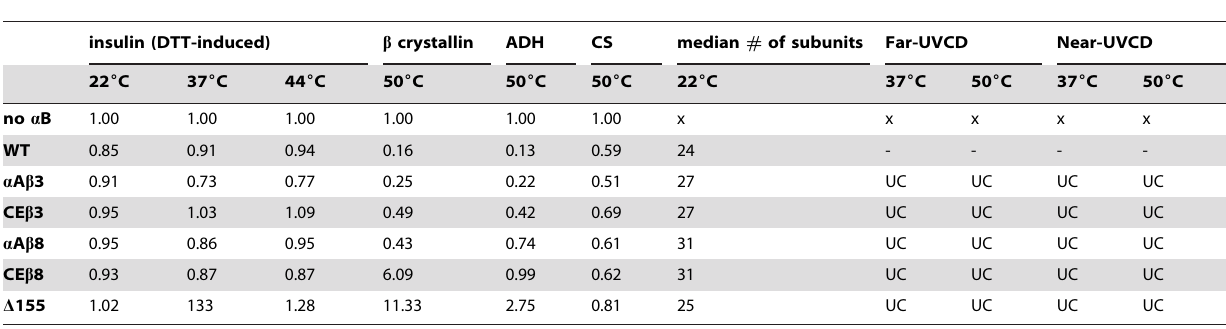
Table 1. Comparison of the chaperone activities of WT and the various a B-crystallin protein constructs used in this study with different client